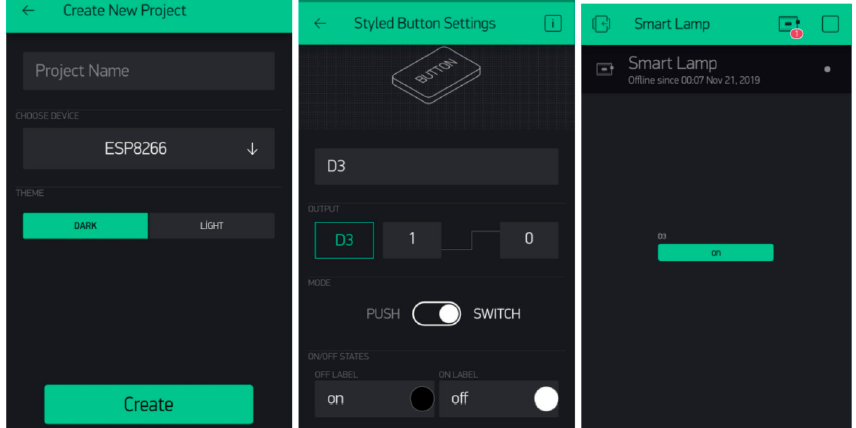
Figure 4. Blynk application interface.